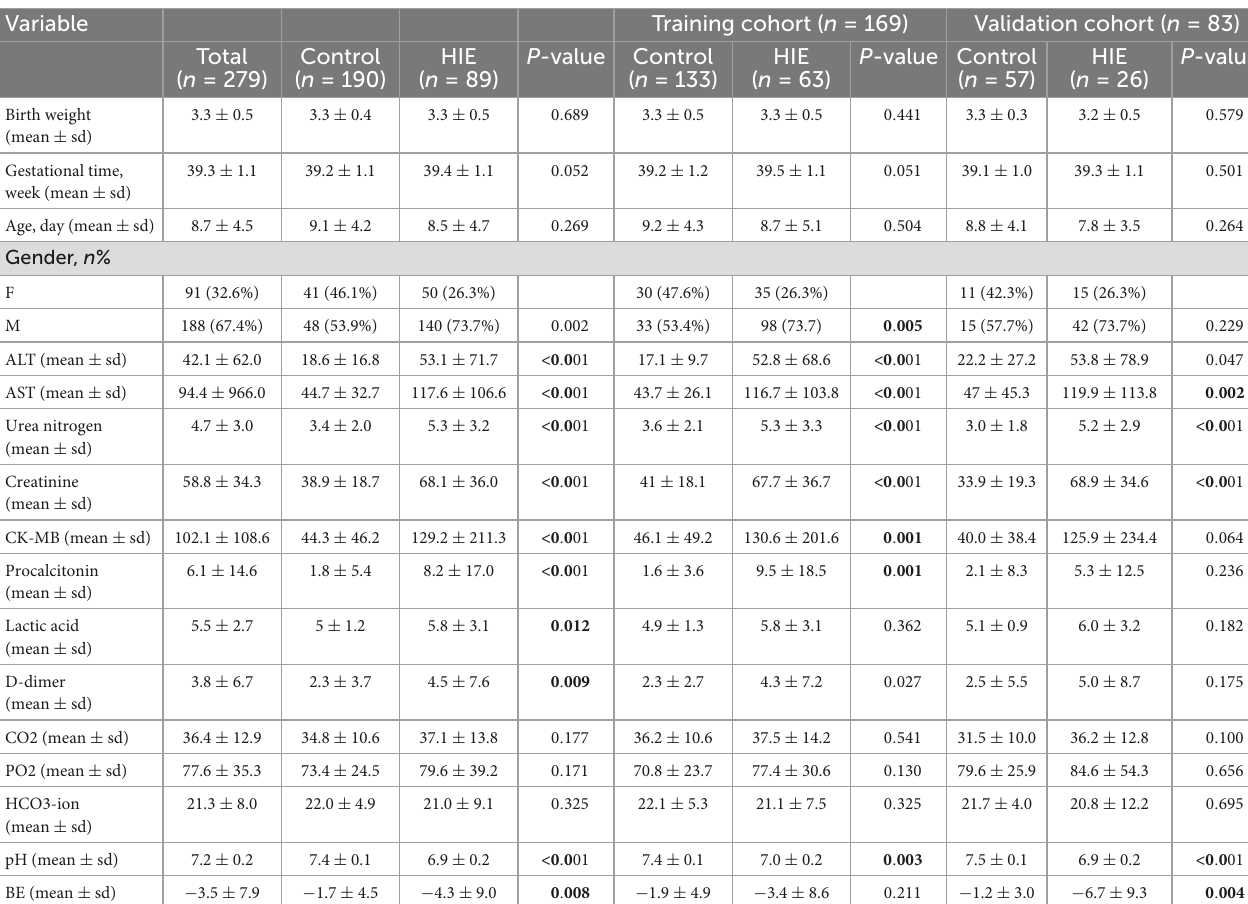
TABLE 1 Comparison of demographic, clinical, laboratory features between control, and HIE groups.